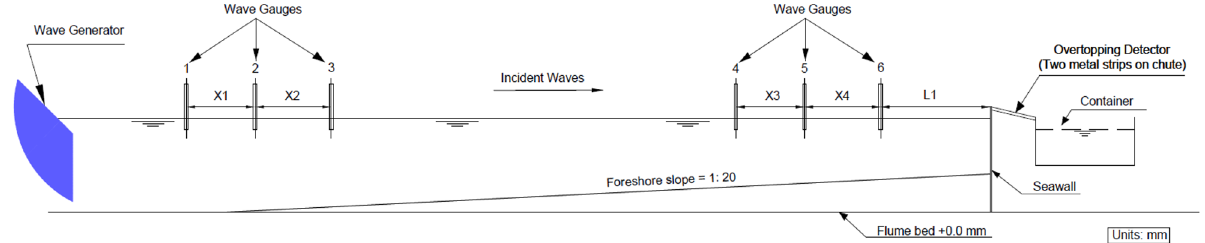
Figure 1. Schematic of the experimental test set-up for Warwick dataset. X1-X4 denotes the spacing of wave gauges and L1 indicates the position of wave gauges from the seawalls in the laboratory set-up (see Ref. 3,6,30 ).